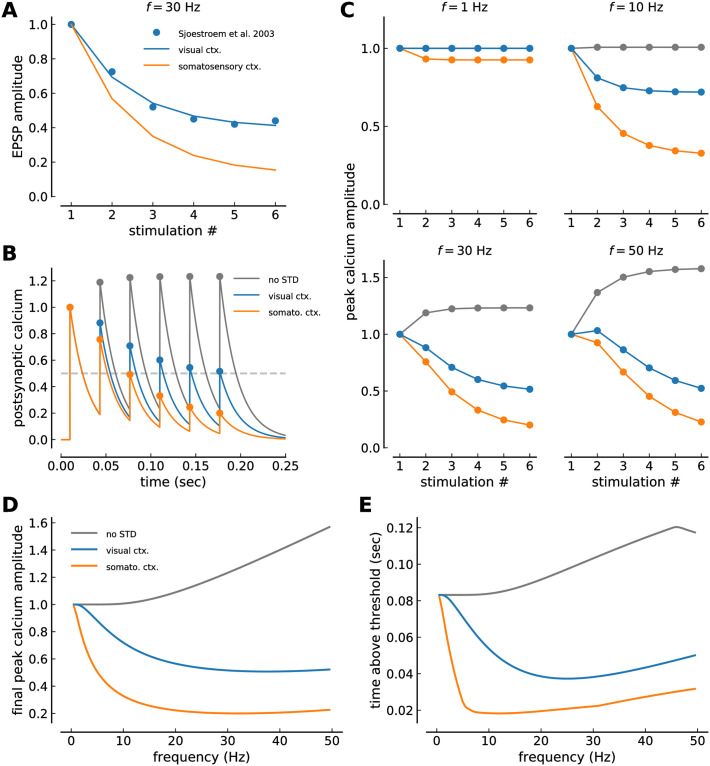
Calcium dynamics with short-term depression in visual and somatosensory cortex.(A) Short-term depression dynamics of EPSP amplitudes in response to a train of six action potentials at 30 Hz in visual- (blue) and somatosensory cortex (orange). The blue points show data from visual cortex (Fig. 1C in [37]) and the blue line depicts the fit of the short-term depression model (Eqs (2) and (3)). EPSP amplitudes in somatosensory cortex have been fitted using the same STD model [36] and the orange line shows the short-term depression model with the somatosensory parameters (see Materials and methods and Table 1). (B) Example simulations of calcium traces with visual cortex STD (blue), somatosensory cortex STD (orange) and no STD (gray line). Traces are generated by six presynaptic stimuli occurring at 30 Hz. Peak calcium amplitudes upon each stimulation are marked by circles. (C) Peak calcium amplitudes in response to a train of six stimuli at various frequencies (marked on top of each panel). Peak amplitudes of the calcium trace (see panel B) at the time of the stimulation are shown for visual cortex STD (blue), somatosensory cortex STD (orange) and no STD (gray line). (D) Final peak calcium amplitude at the sixth presynaptic stimuli as function of stimulation frequency for visual cortex STD (blue), somatosensory cortex STD (orange) and no STD (gray line). The plotted peak corresponds to the last point in panel C. (E) Time spent above threshold by the calcium trace during the train of six presynaptic stimuli as function of stimulation frequency. For illustration, a threshold of θ = 0.5 is used. Color code as in panel D. An initial calcium amplitude of 1 is used for all cases and the calcium decay time constant is taken to be τCa = 20 ms in B-E. All simulations of the calcium dynamics (panels B—E) are based on the calcium-based plasticity model with STD dynamics (Eqs (2) and (3)).